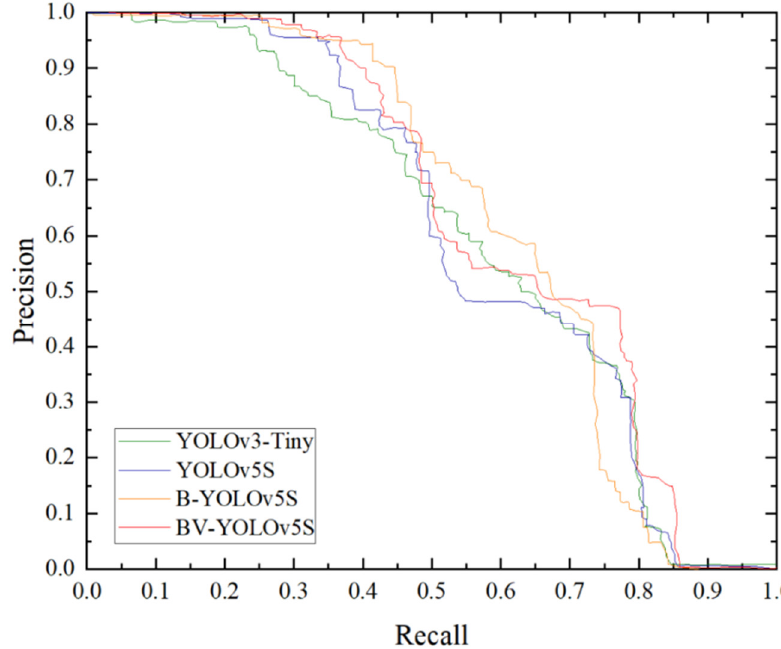
Figure 7. PR curves of four pavement defect detection models on the test set.